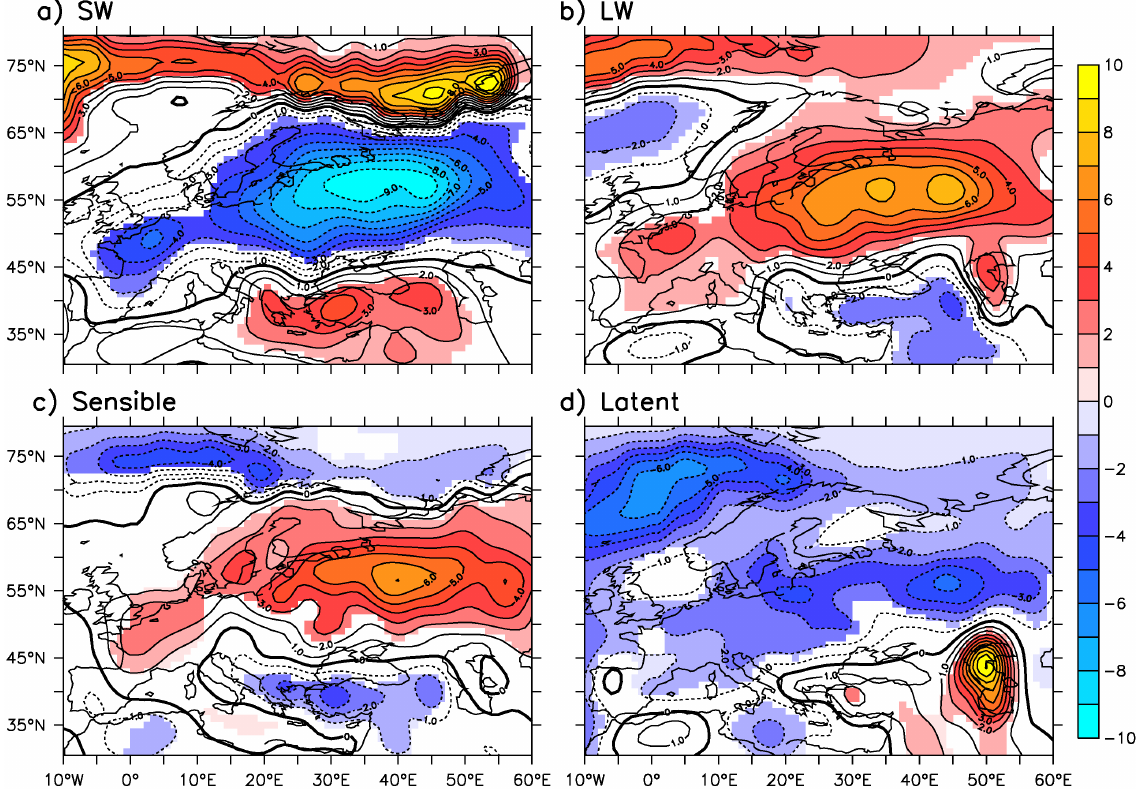
Fig. 5. Same as Fig. 3 but for (a) the net shortwave radiation at the surface, (b) the net longwave radiation at the surface, (c) the sensible heat flux, (d) the latent heat flux. All panels are expressed in Wm − 2 /Wm − 2 Figure 5. Same as Figure 3 but for a the net shortwave radiation at the surface, b the net 2 longwave radiation at the surface, c the sensible heat flux, d the latent heat flux. All panels 3 are expressed in W.m -2 /W.m -2 . 4